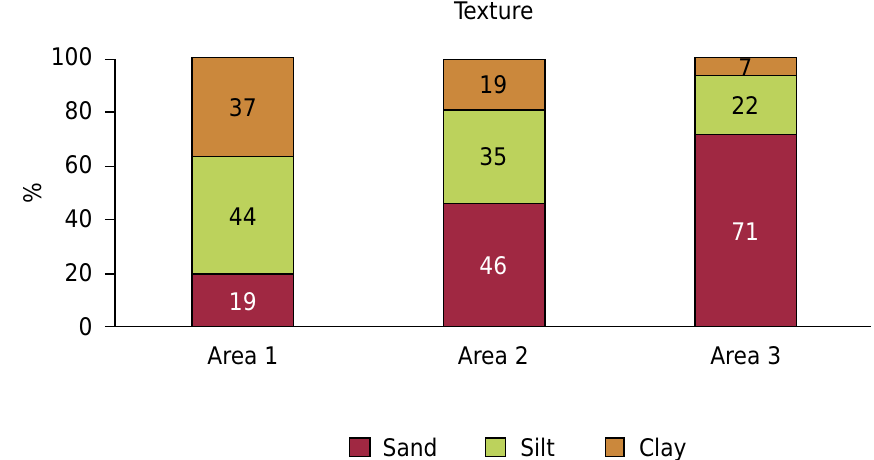
Figure 2. Average distribution of sand, silt, and clay for areas 1, 2, and 3.